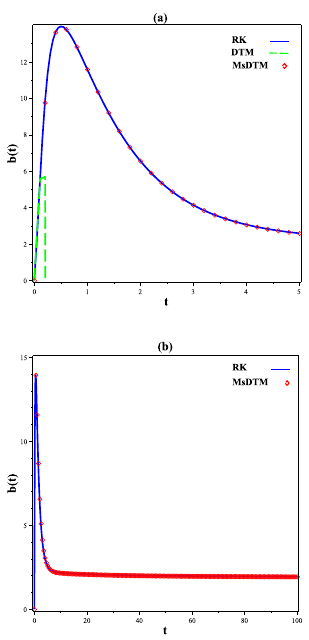
Figure 5: The density of the birds infected with avian influenza with r 0 = 1.06 and R 0 ≈ 3.5 .